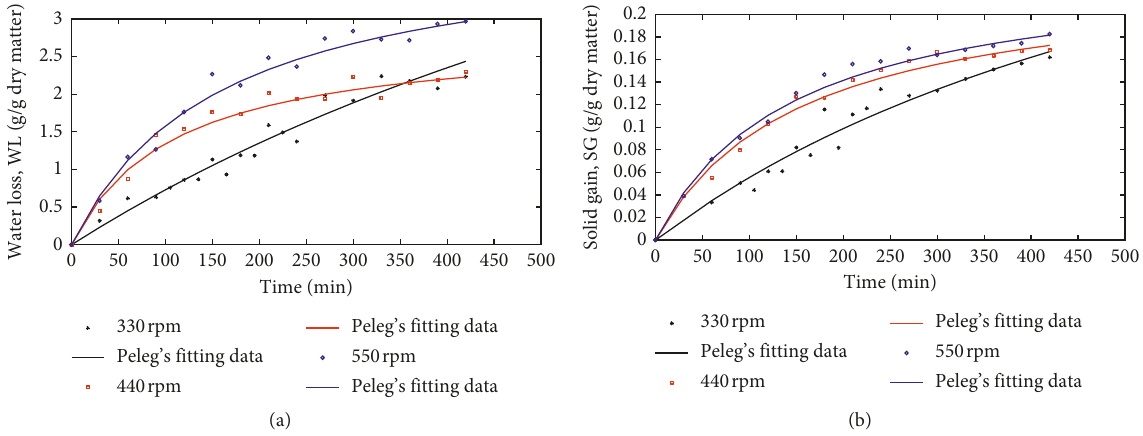
Figure 4: Effect of stirring speed on mass transfer during the OD of pomegranate seeds: (a) water loss and (b) solid gain ( C and sample/solution weight ratio